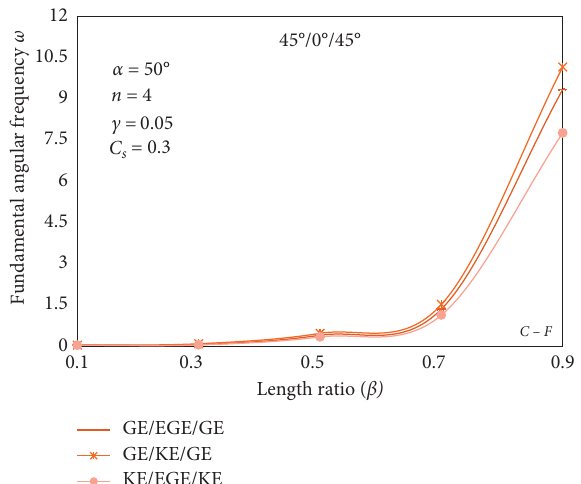
Figure 12: Influence of length ratio on the fundamental angular frequency of three-layered conical shells with different material